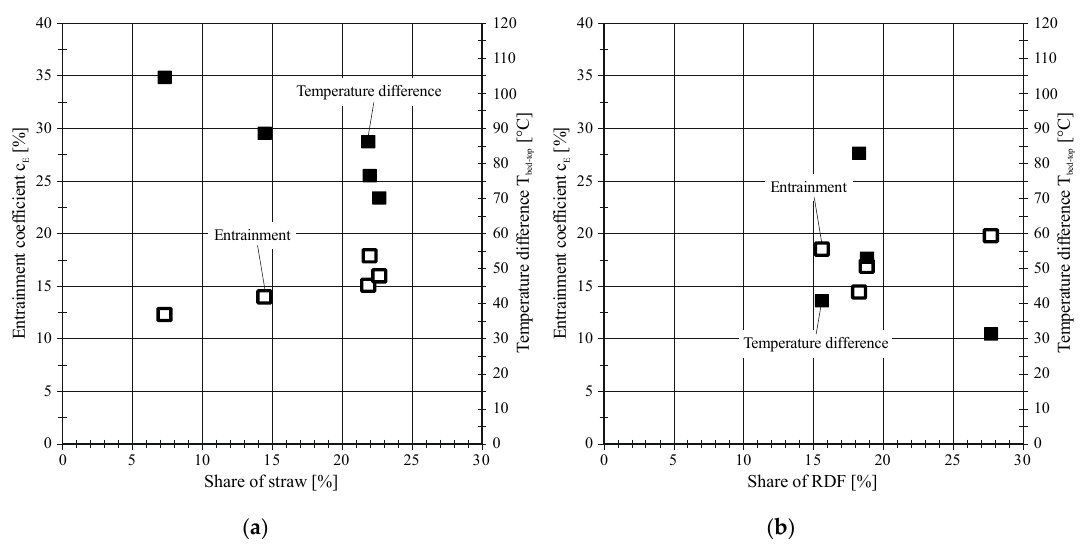
Figure 6. Entrainment coefficient and temperature difference (similar load/flue gas flow rate): straw ( a ) and RDF ( b ).